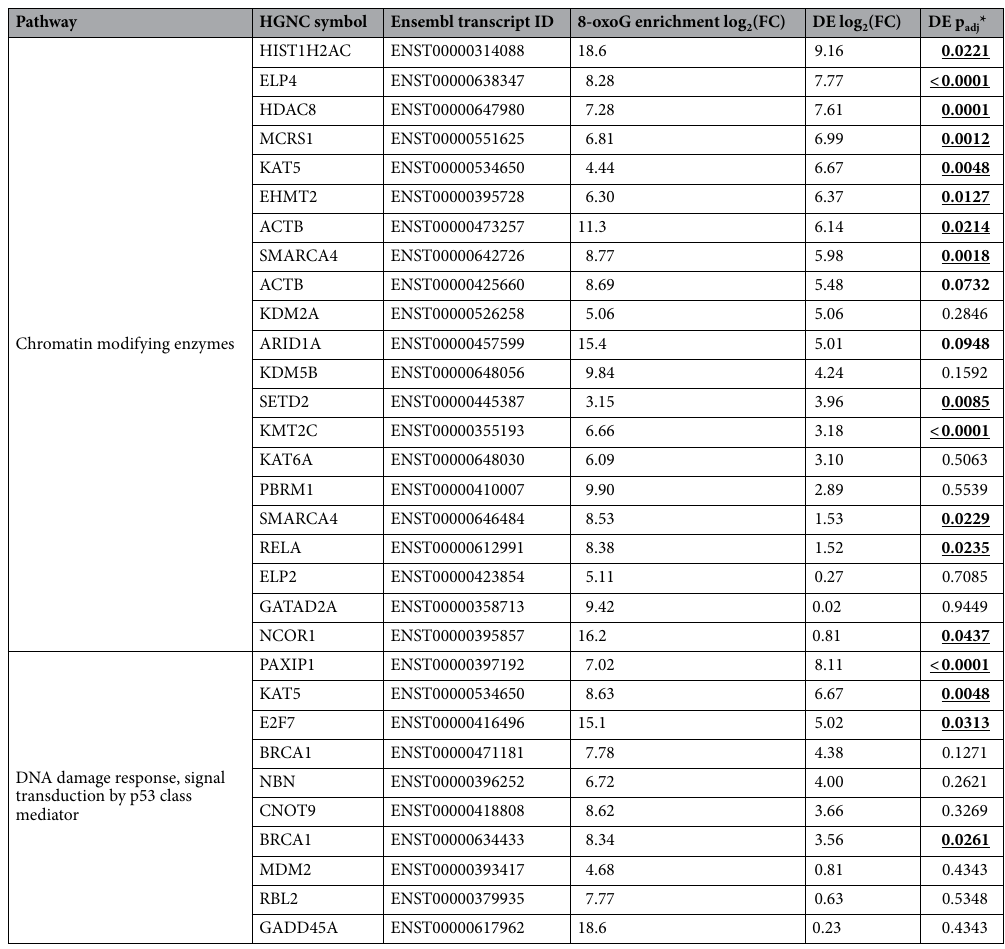
Table 1. Fold-change in 8-oxoG enrichment and differential expression (DE) in the chromatin modification and DNA-damage response pathways after formaldehyde exposure. *Differentially expressed transcripts with p adj < 0.1 are shown in bold and with p adj < 0.05 are